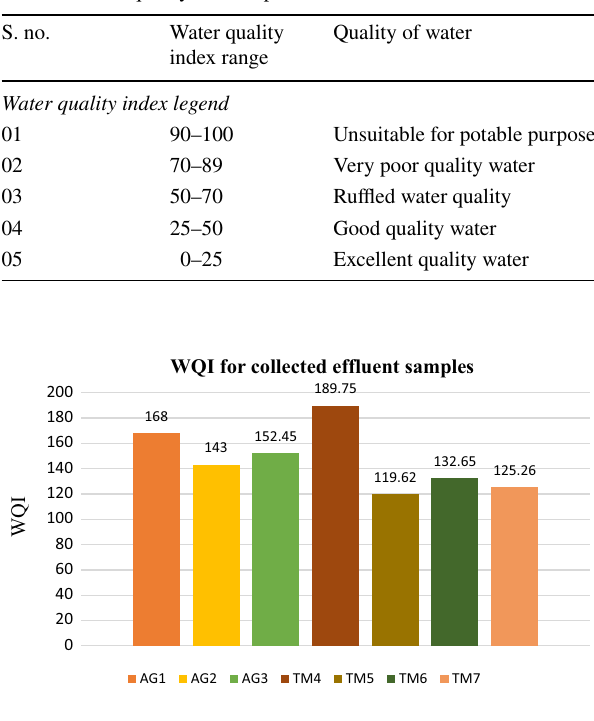
Fig. 1 Diagrammatic representation of calculated water quality index (WQI) for all the collected effluent